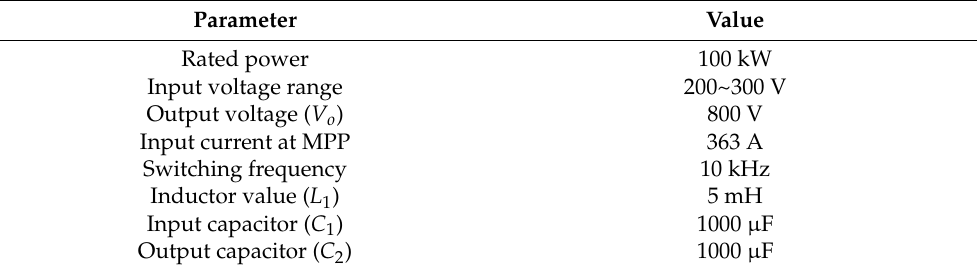
Table 2. Design parameters of the boost converter